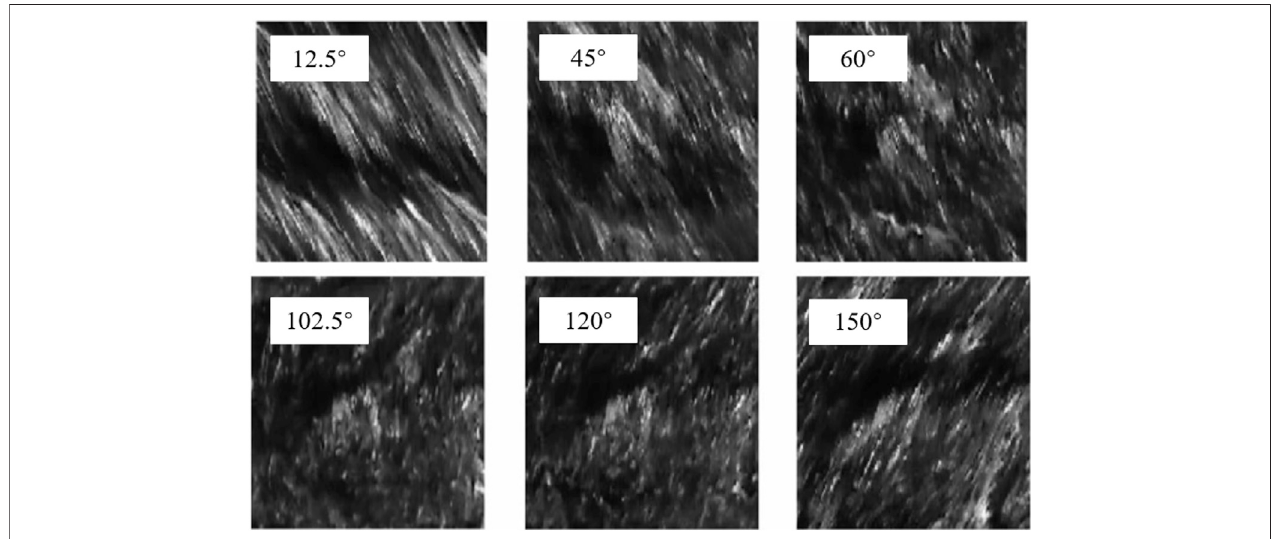
FIGURE 4 | The space-time images of search lines at 6 typical angles. (A) 12.5 ° , (B) 45 ° , (C) 60 ° , (D) 102.5 ° , (E) 120 ° , (F) 150 ° .